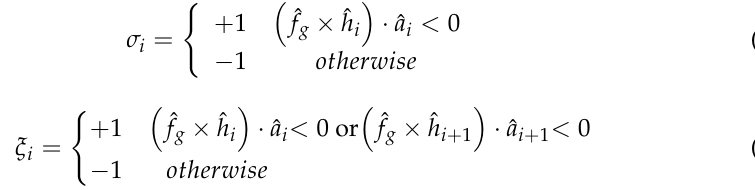
Figure 14a shows the stable cone model for the lateral motion of the robot on the slope. When point O (cid:48) coincides with point N 3 , the robot is in a critical angle tipping state. Figure 14b shows the stable cone model for the longitudinal motion of the robot on the slope, where f g gradually points to point N 8 as the slope increases. When O (cid:48) coincides with point N 8 , the robot is in a critical angle tipping state. When the structural parameters of the robots are certain, the stability of the robot can be improved by increasing the coefficient of friction between the robot and the ground and by reducing the height of the robot’s center of